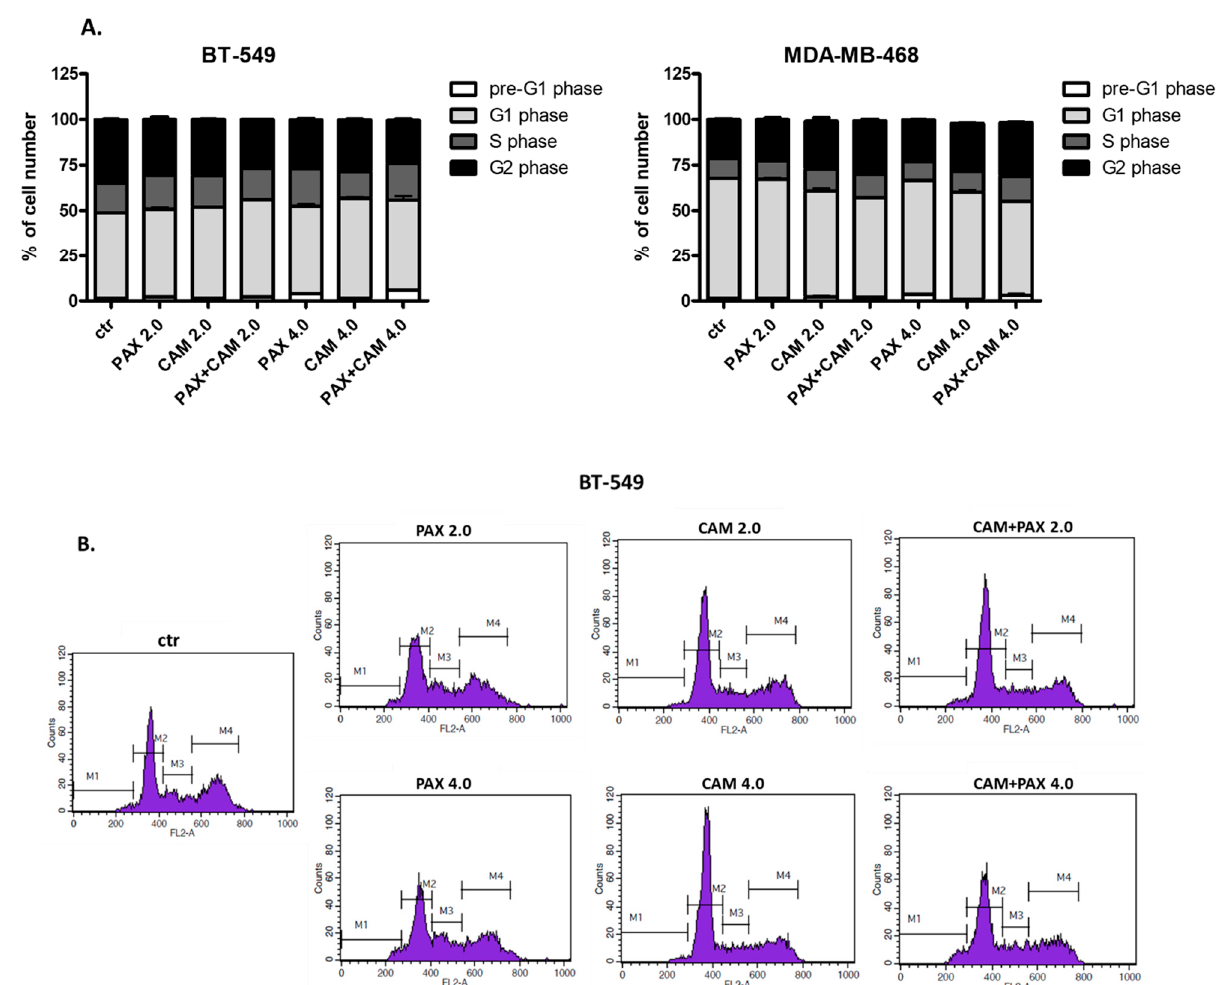
Figure 9. ( A ) Influence of CAM and PAX on cell cycle progression in the BT ‐ 549 and MDA ‐ MB ‐ 468 TNBC cells. BC cells were exposed to an individual or concomitant CAM and PAX treatment for 48 h using selected ratios (2.0 = IC 50 , 4.0 = 2IC 50 ) of the IC 50 determined in the MTT assay, stained with propidium iodide (PI) and analyzed by FACS. The data are presented as the means ± standard deviation (±SD). ( B ) Representative histograms from the FACS analysis of the BT ‐ 549 TNBC cells after a 48 h incubation with a medium (ctr), PAX, CAM and PAX + CAM (2.0 = IC 50 , 4.0 = 2IC 50 ). M1 ‐ pre ‐ G1 phase; M2 ‐ G1 phase; M3 ‐ S phase; M4 ‐ G2 phase. Table 3. Cell cycle distribution of BT ‐ 549 and MDA ‐ MB ‐ 468 TNBC cells exposed to an individual or concomitant CAM and PAX treatment for 48 h using selected ratios (2.0 = IC 50 , 4.0 = 2IC 50 ) of the IC 50 determined in the MTT assay, stained with propidium iodide (PI) and analyzed by FACS. The data in the table are presented as the means ± standard deviation (±SD) of the means.